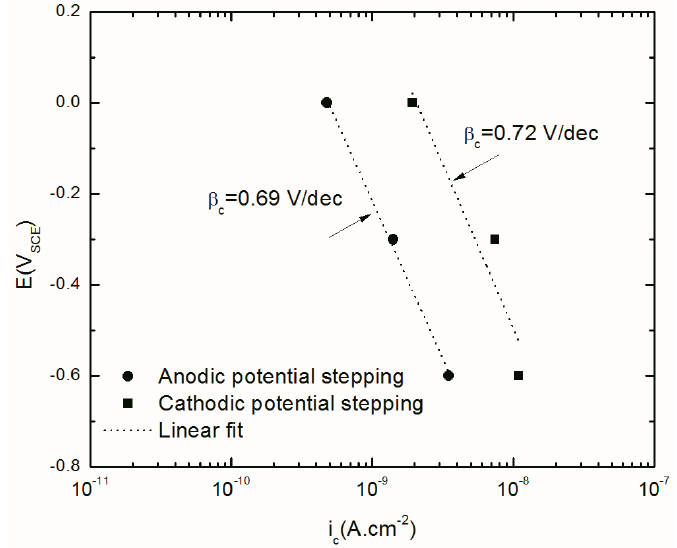
Figure 11. current density of AA2098 – T851 alloy in 0.1 M NaHCO 3 after 24 h of polarization at Figure 11. Current density of AA2098–T851 alloy in 0.1 M NaHCO 3 after 24 h of polarization at different potentials in contact with 1 atm CO 2 (pH = 6.7, 25 °C) during the anodic and cathodic di ff erent potentials in contact with 1 atm CO 2 (pH = 6.7, 25 ◦ C) during the anodic and cathodic potential potential stepping obtained from optimization of EIS results. stepping obtained from optimization of EIS